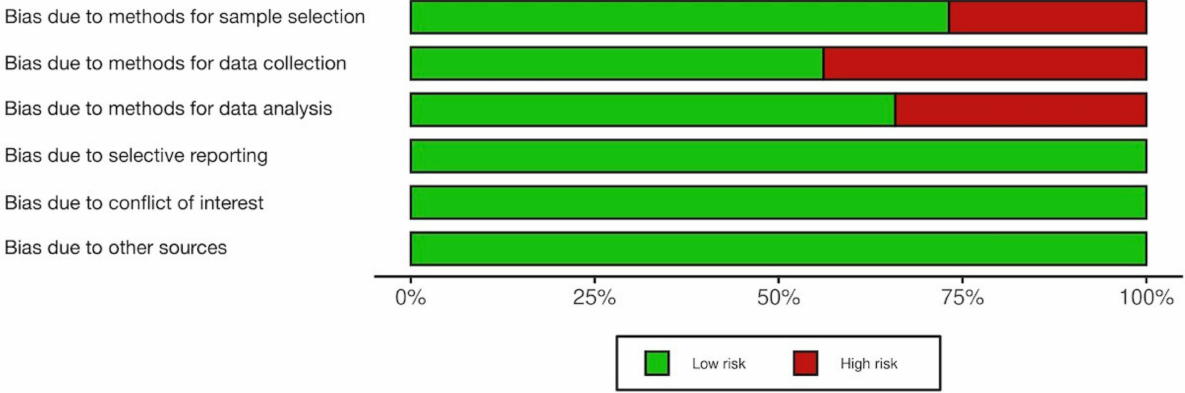
Figure 3. Overall assessment on the risk of bias of the included